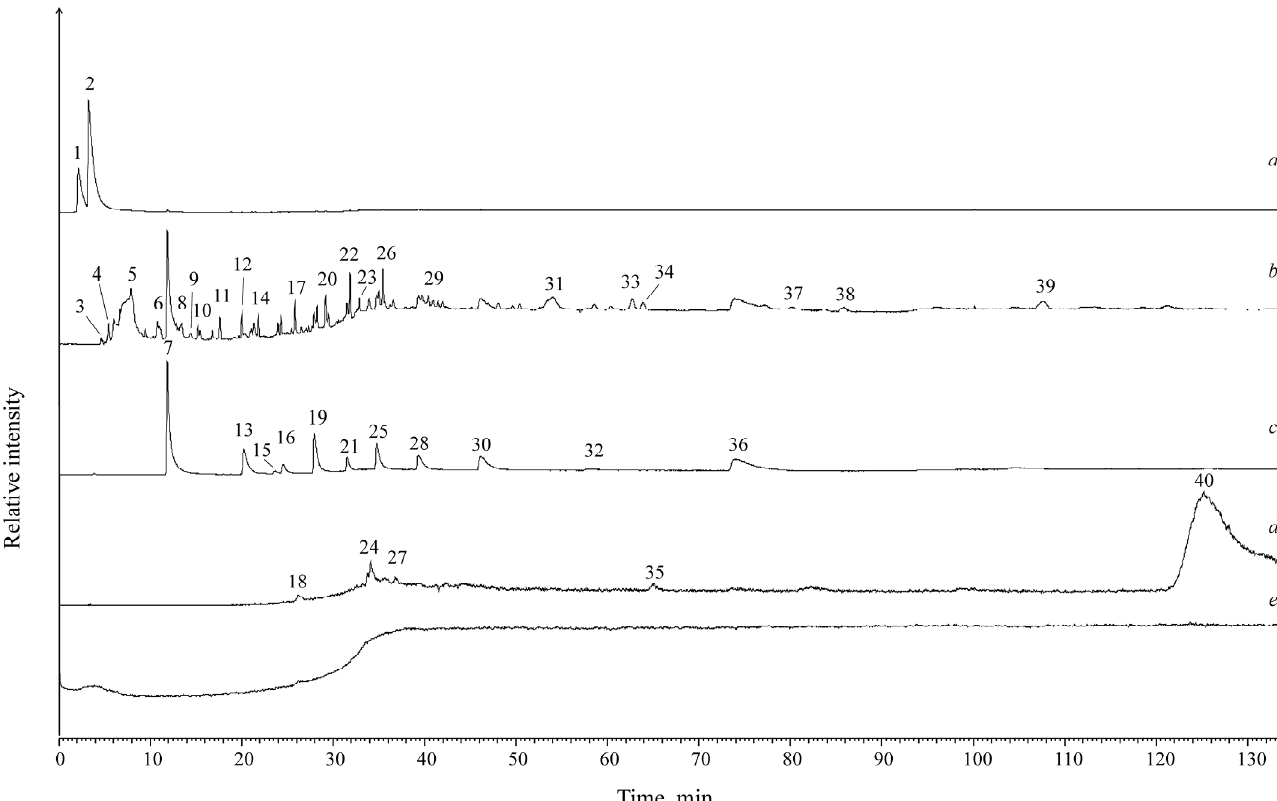
Figure 6. Results of GC-MS analysis of volatile components extracted from the cordierite marginal zone of the Muzkol metamorphic complex, Tajikistan (sample 4). Chromatogram a is a total ion current (TIC) chromatogram and reconstructed ion chromatograms for ion current are presented in: